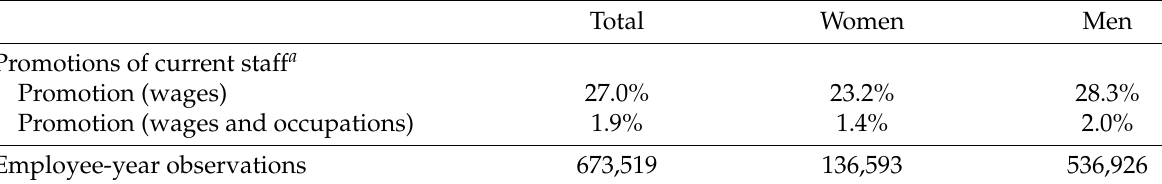
Table 1: Promotions for current